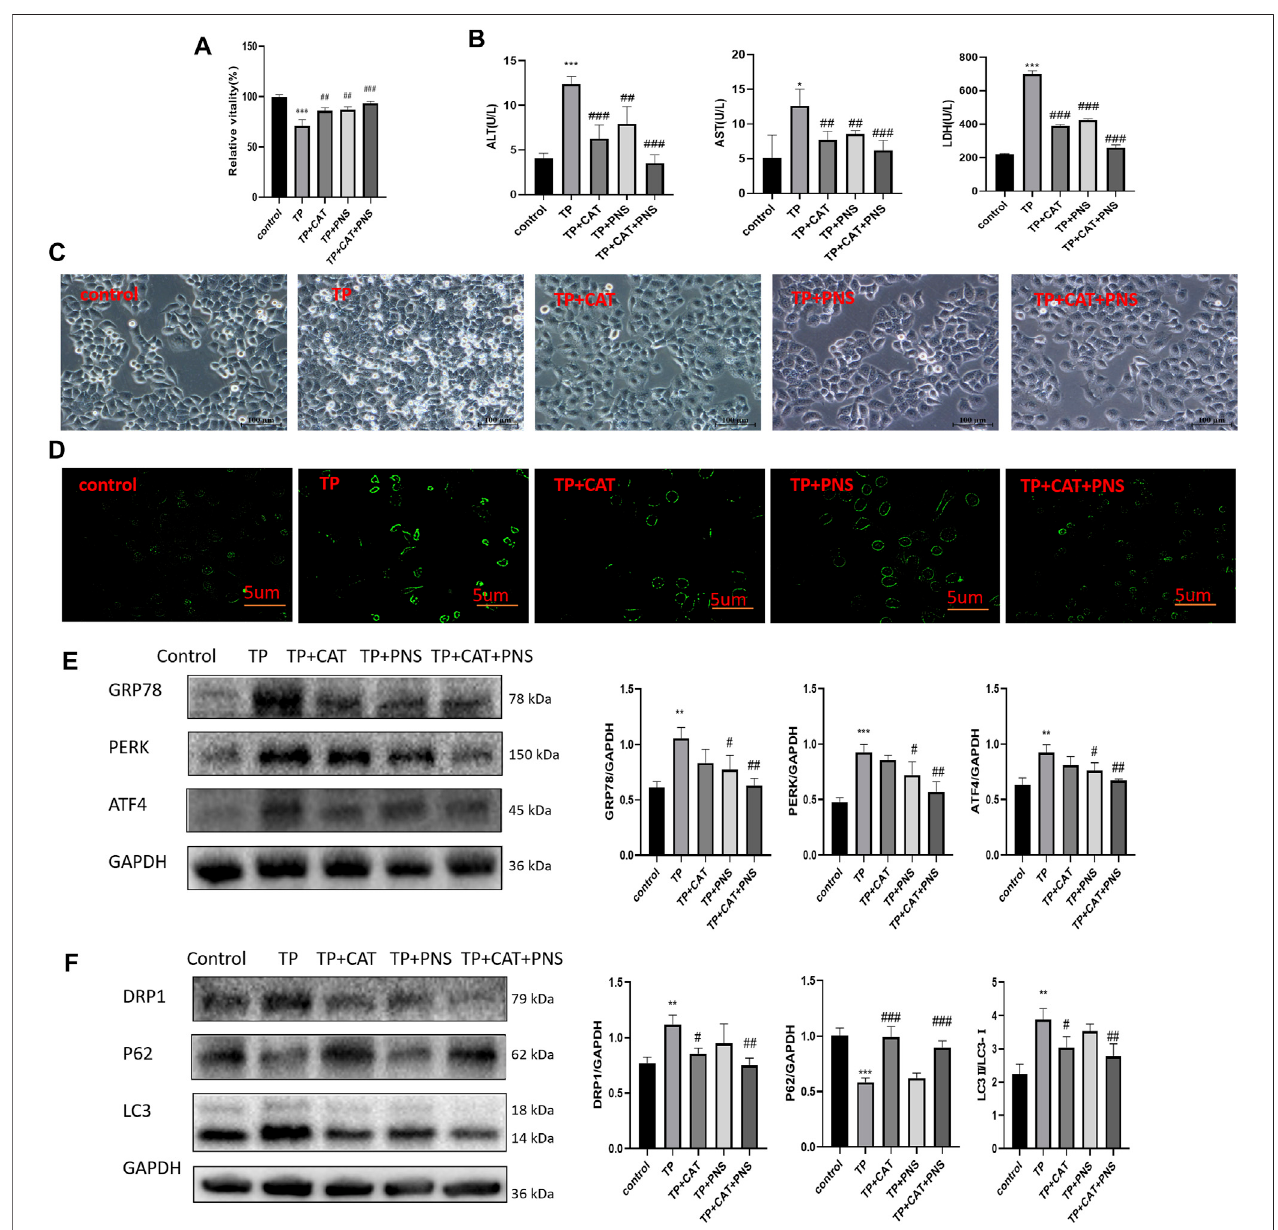
FIGURE 8 | The pharmacodynamics combination of QTF reduced TP-induced damage by down-regulating excessive mitophagy by the PERK-ATF4 pathway in HepaRG cells. (A) CAT and PNS improved the TP-induced reduction of HepaRG cell viability. (B) CAT and PNS improved the levels of ALT, AST, and LDH in the supernatantofHepaRGcellsinducedbyTP. (C) CATandPNSimprovedtheTP-inducedmorphologicaldamagetoHepaRGcells.200magni fi cation,Scalebar:10 µm. (D) CAT and PNS reduced the TP-induced increase of autophagosomes in HepaRG cells. The green fl uorescence represents autophagosomes. 200 magni fi cation, Scale bar: 5 µm. (E) CAT and PNS reduced the expression level of GRP78, PERK, and ATF4 in HepaRG cells induced by TP. (F) CAT and PNS reversed theexpressionlevelofDRP1,P62,andLC3inHepaRGcellsinducedbyTP.Comparedwiththecontrolgroup, *p < 0.05,**p < 0.01,***p < 0.001 ;comparedwiththeTP group, # p < 0.05, ## p <